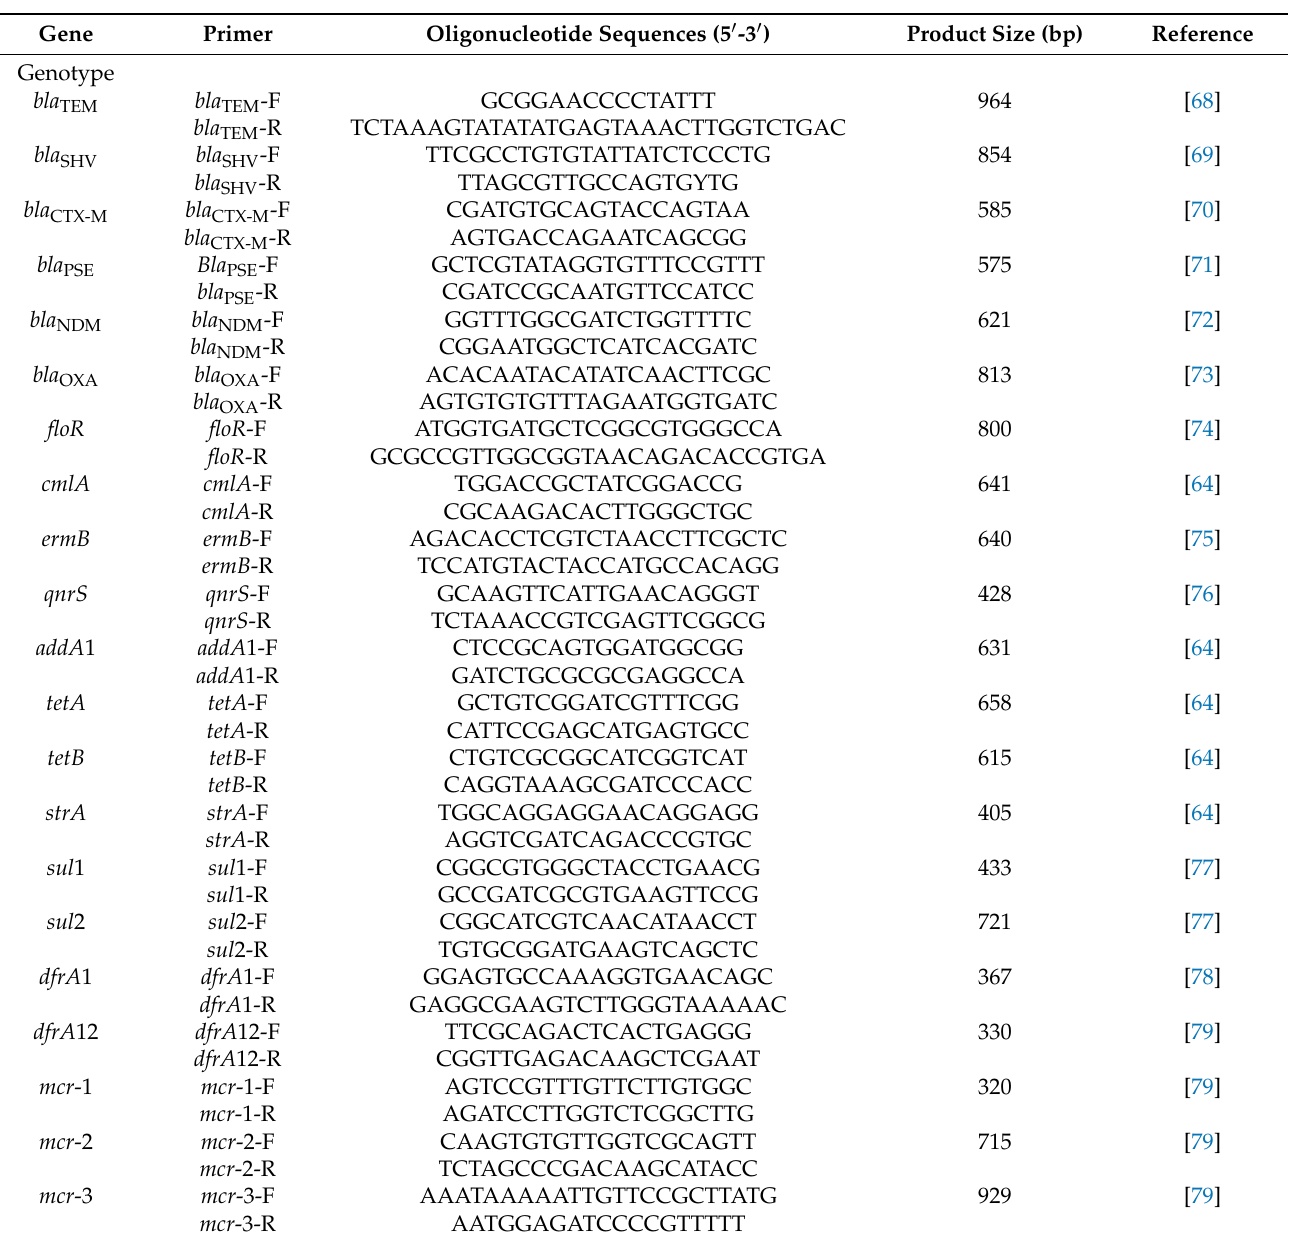
Table 6. Primers used in this